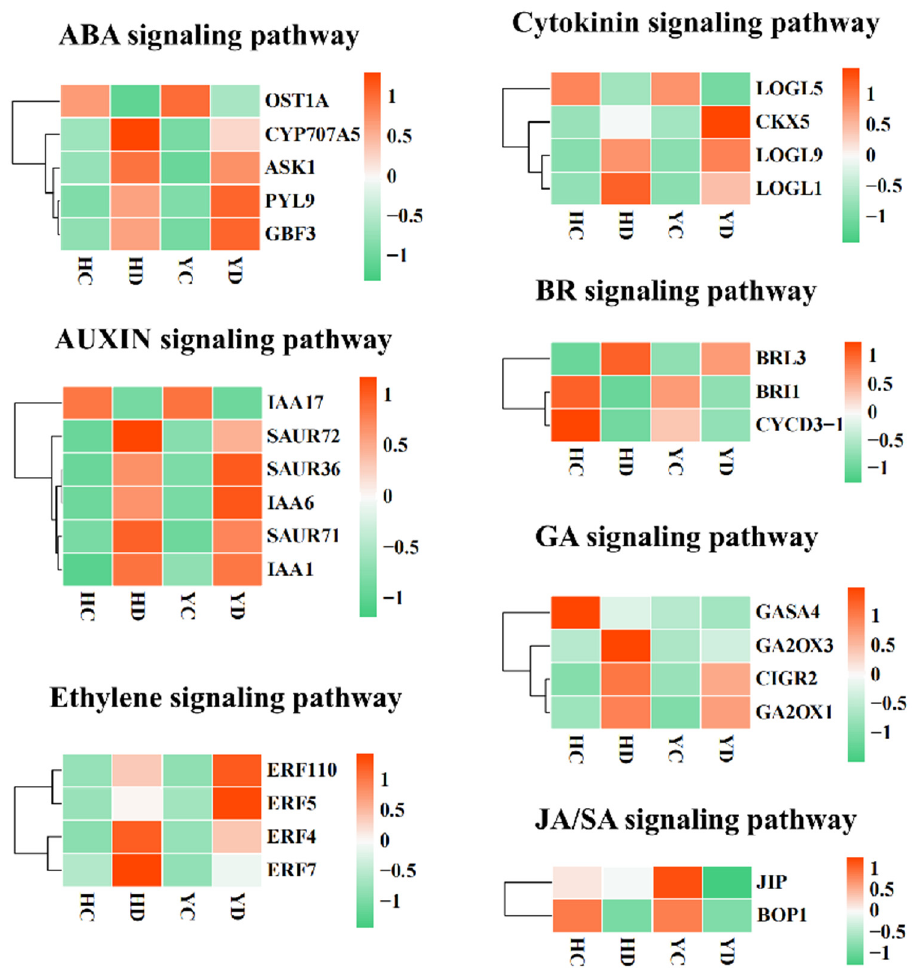
Figure 2. The expression profiles of the genes related to plant hormone signal transduction in HQ and YS10. These hormone pathways include the ABA signaling pathway, auxin signaling pathway, ethylene signaling pathway, cytokinin signaling pathway, BR signaling pathway, GA signaling pathway, and JA and SA signaling